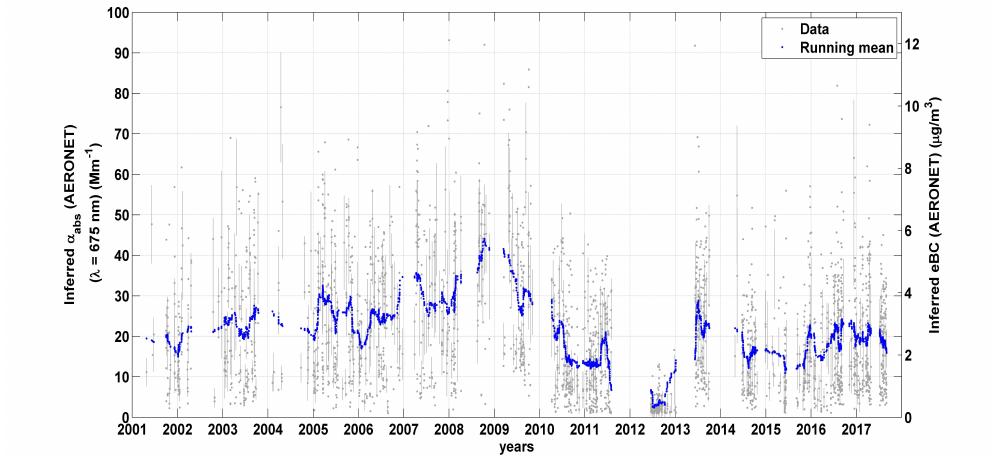
Figure 4. Time series of surface aerosol light absorption coefficients α abs ( λ = 675 nm) inferred from AERONET data, at the site of Rome Tor Vergata, from January 2001 to August 2017 (2924 data points). Grey markers show the inferred α abs (measurement error bars are indicated by grey lines). Blue markers show the relevant (55 points) running mean. On right y -axis the corresponding eBC mass concentration values ( µ g/m 3 ) are